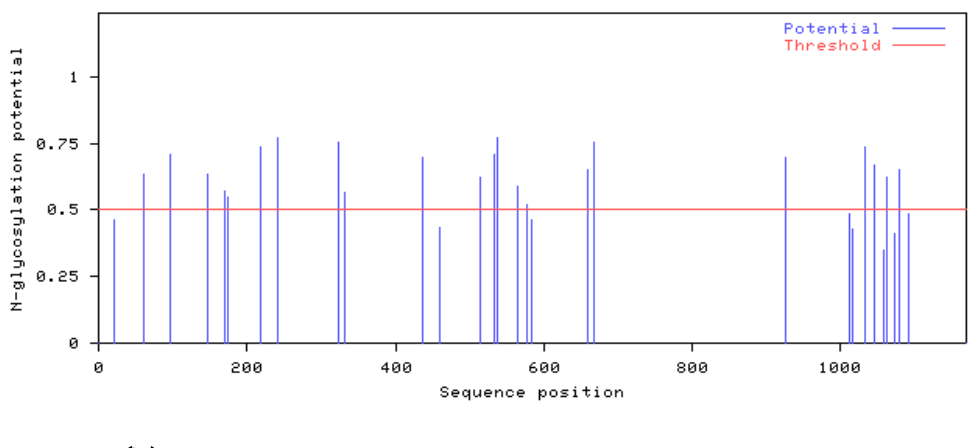
(b ) HCoV-229E spike protein N-glycosylation site